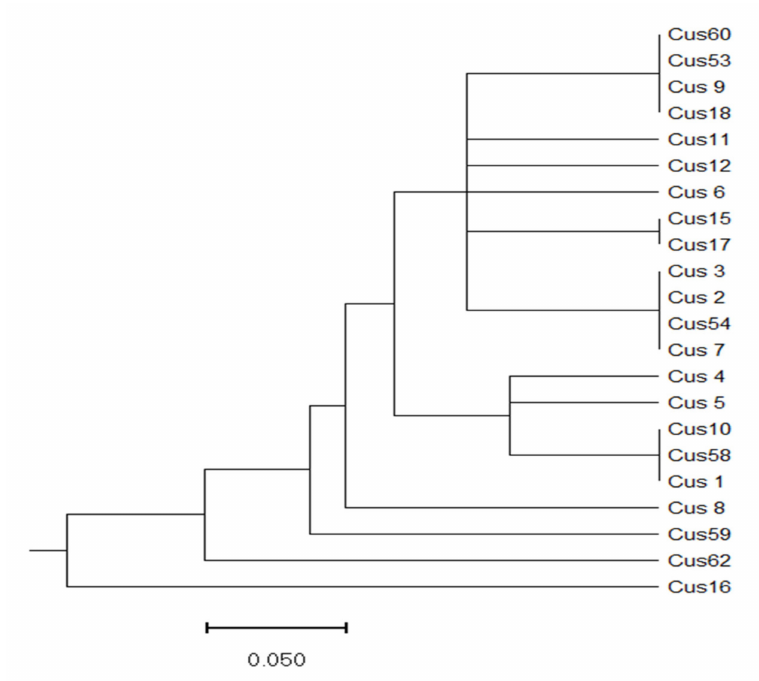
Figure 6. UPGMA tree of Cuscuta campestris populations based on RAPD analysis with four decamer primers. Scale bar is genetic